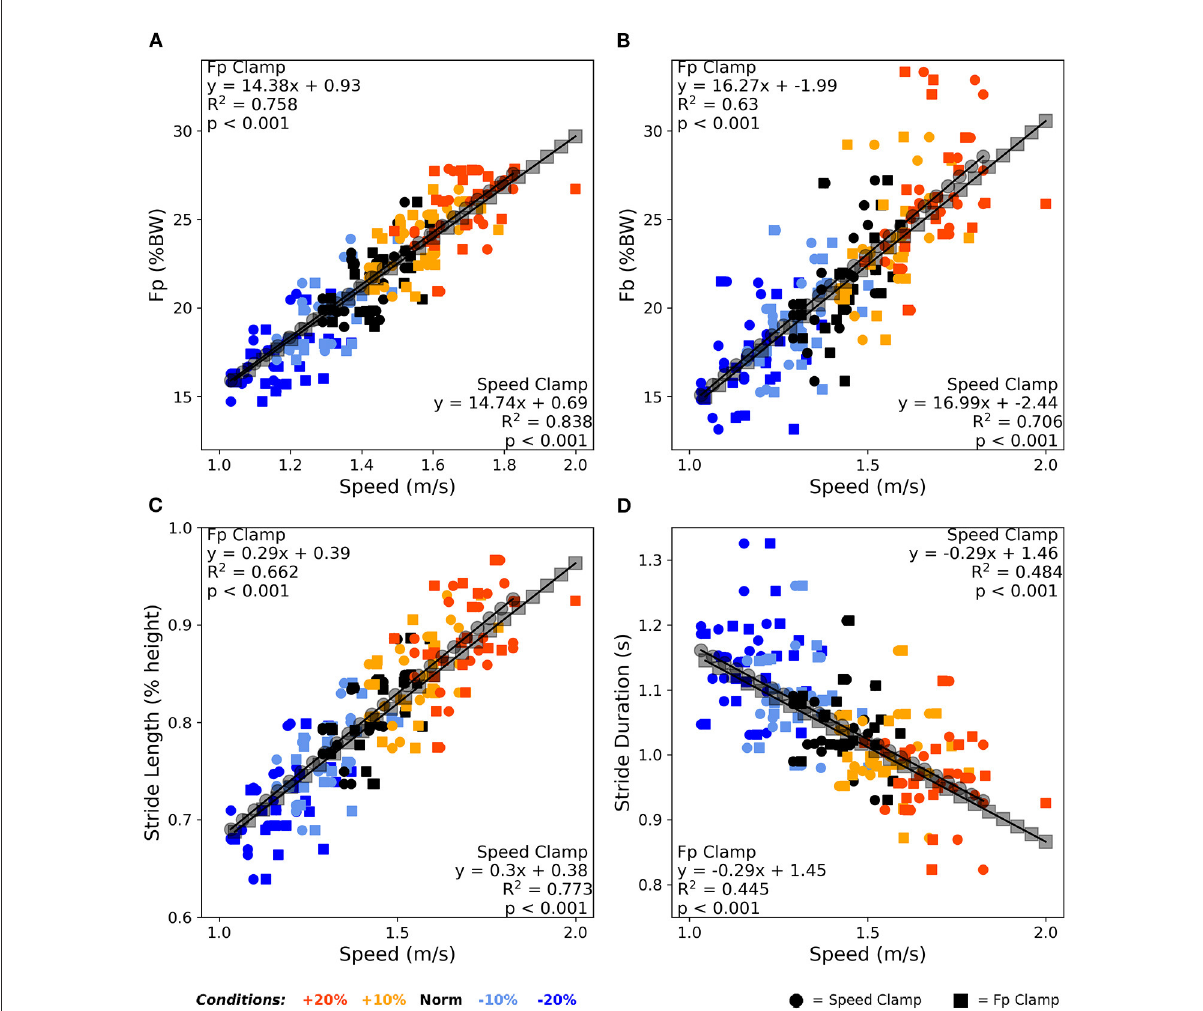
FIGURE4 Averaged over the final 2min, walking speed correlated very strongly with F P (A) , strongly with F B (B) and stride length (C) , and moderately with stride duration (D) . Participants responded nearly identically between clamp types across these four outcome variables to alter their walking speed over the condition intensities. BW, body